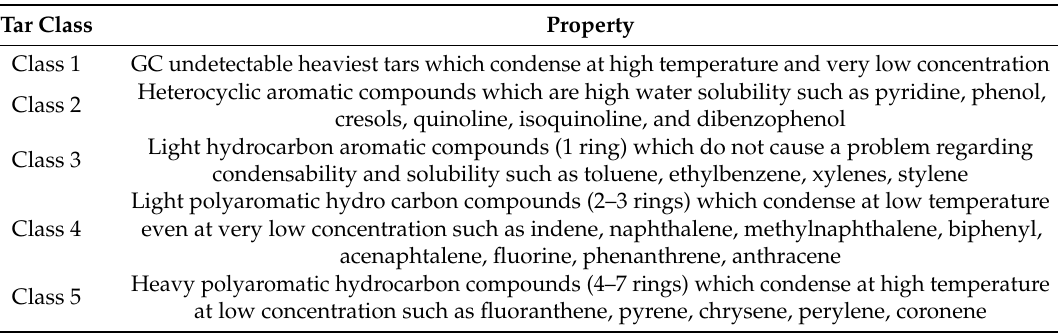
Table 3. Classification of tar based on molecular weight [9,10].